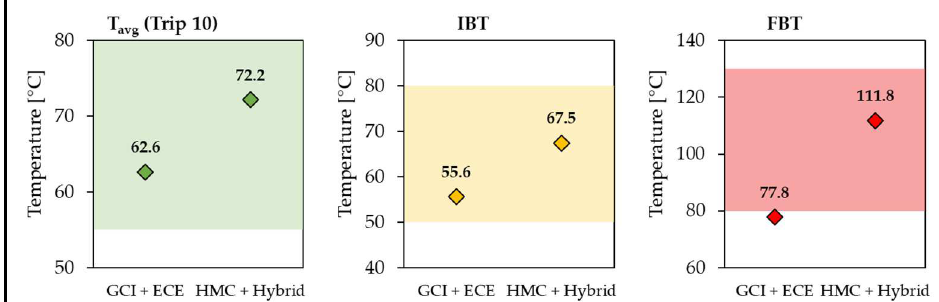
Figure 15. Temperatures of the HMC pairing compared to the GCI pairing during WLTP Brake Cycle Trip 10. The colored background areas represent the GTR temperature corridors valid at the time the investigations were conducted.